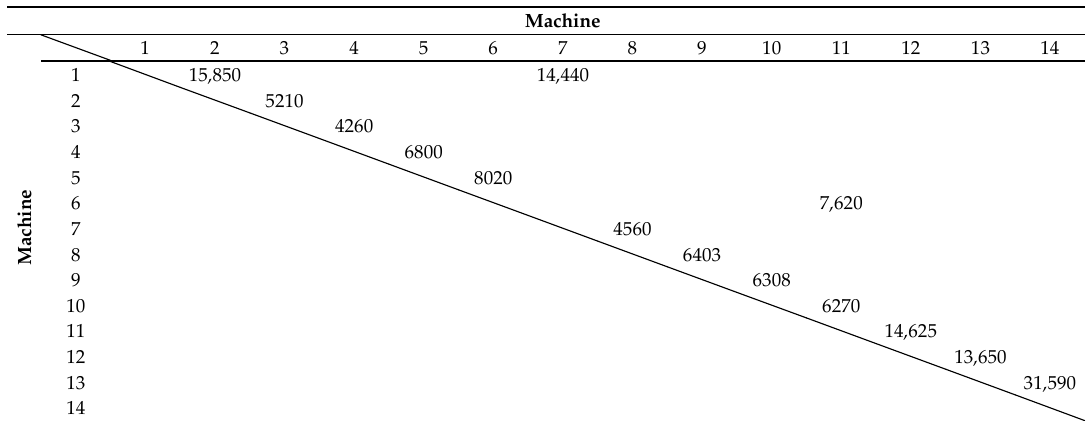
Table 7. Adjacency weight matrix f’ ij .